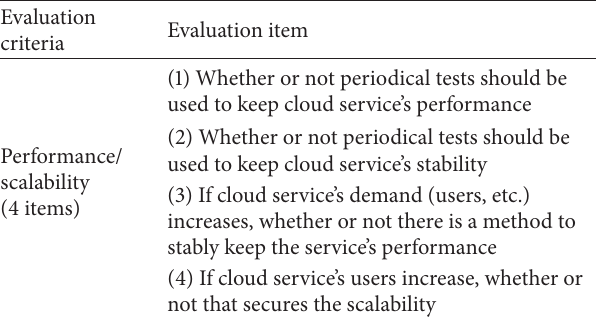
Table 5: Evaluation items of performance and